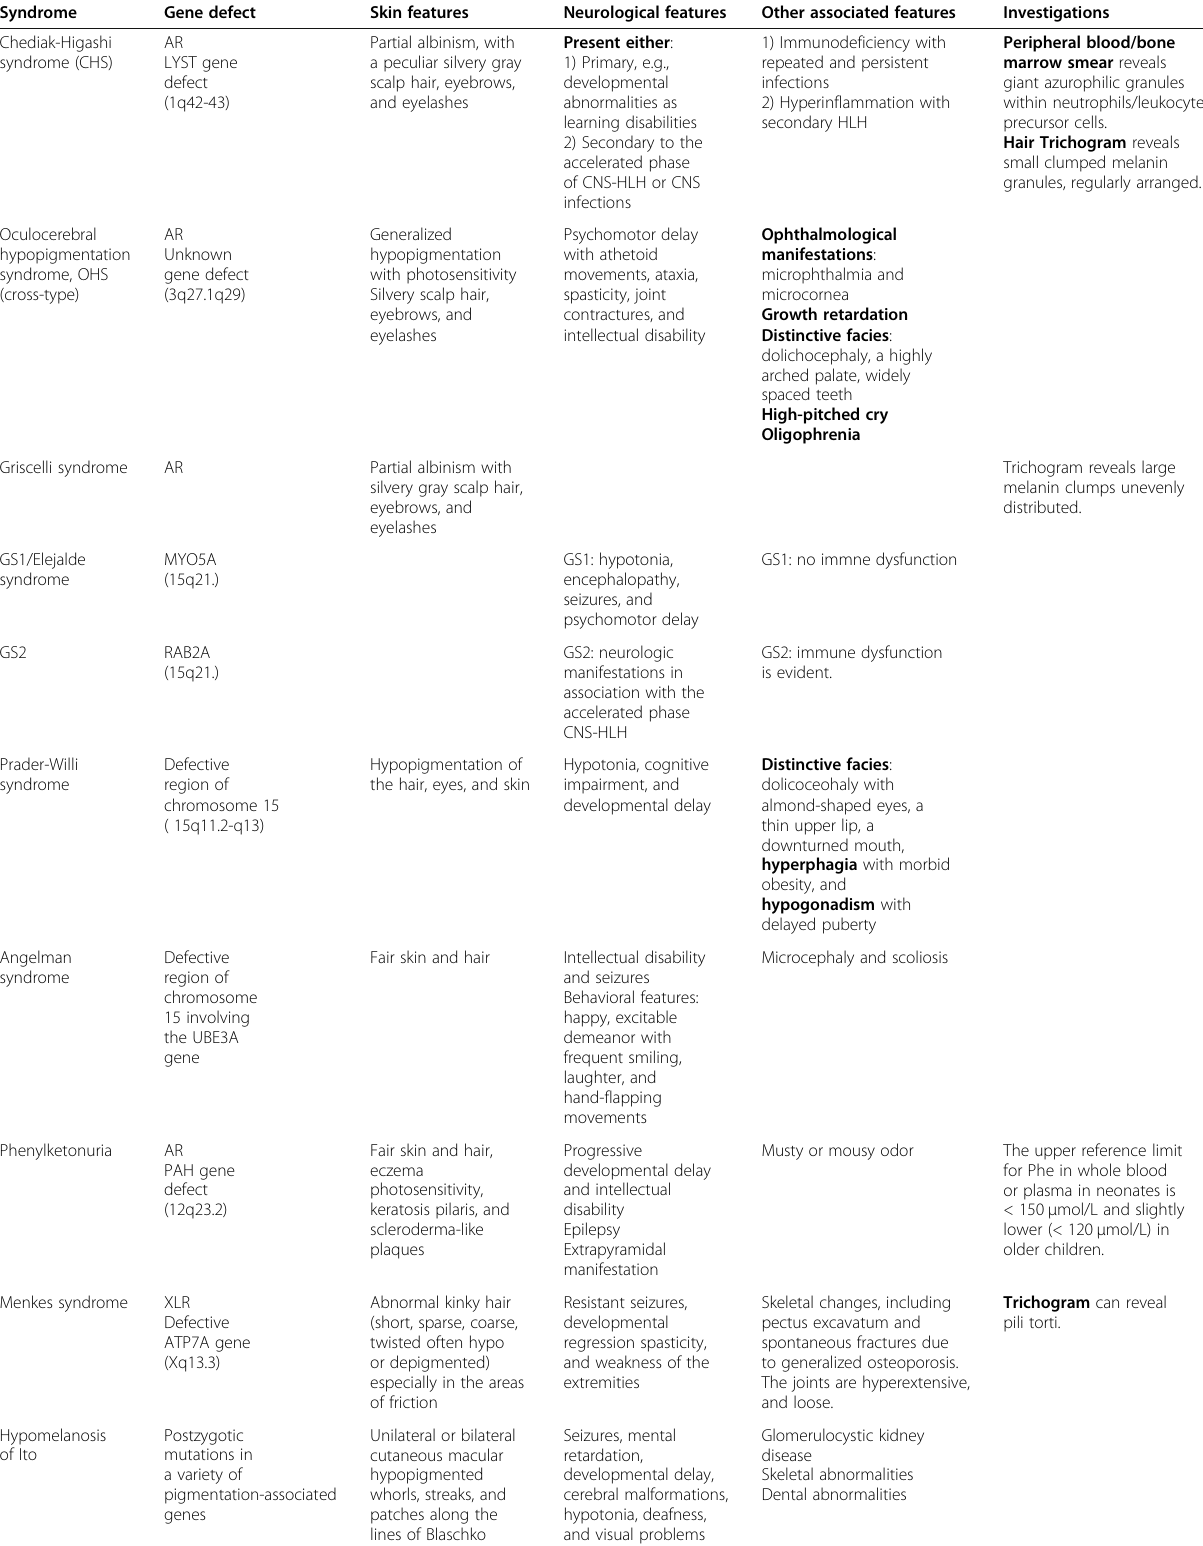
Table 1 Differential diagnosis inherited hypopigmentation disorders associated with neurological